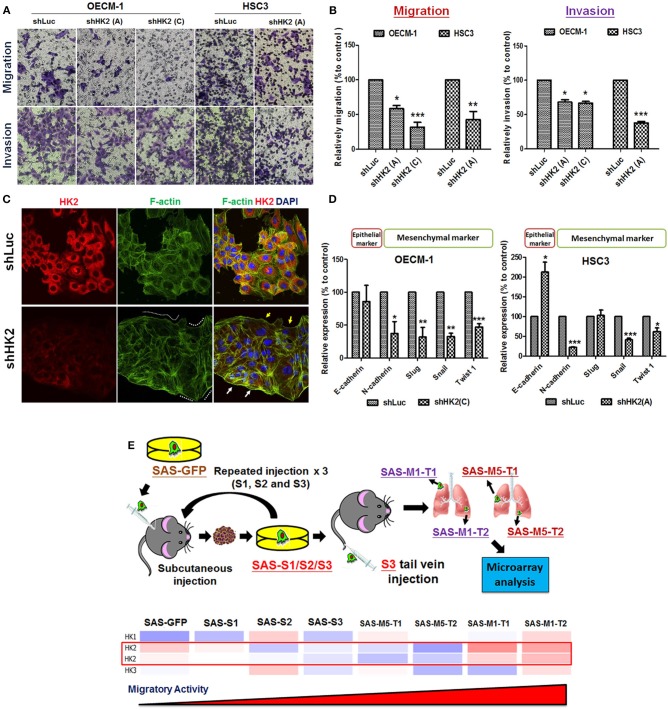
Cell motility changes in HK2-silencing HNSCC Cells. (A,B) Transwell cell migration and invasion assays were performed in HK2-silencing HNSCC cells. HK2 knockdown led to significantly less migration and invasion in HNSCC cells. The changes of cell motility could result from (C) rearrangement of lamellipodia-like (dot-lined) and filopodia-like F-actin structures. HK2-silencing OECM-1 cells showed heterogeneous population, whereas cells with higher HK2 expression exhibited more condense F-actin structure (white arrows), while cells with less HK2 expression displayed little F-actin staining; and (D) altered EMT-associated mRNA expression. (E) Microarray analysis showed an increasing HK2, but not HK1 and HK3, mRNA expression in in situ injected (S1/2/3) and distant metastatic (M1/M5) HNSCC derived tumors. Data are presented as mean ± SEM (N ≥ 3). ***p < 0.001, **p < 0.01, and *p < 0.05.